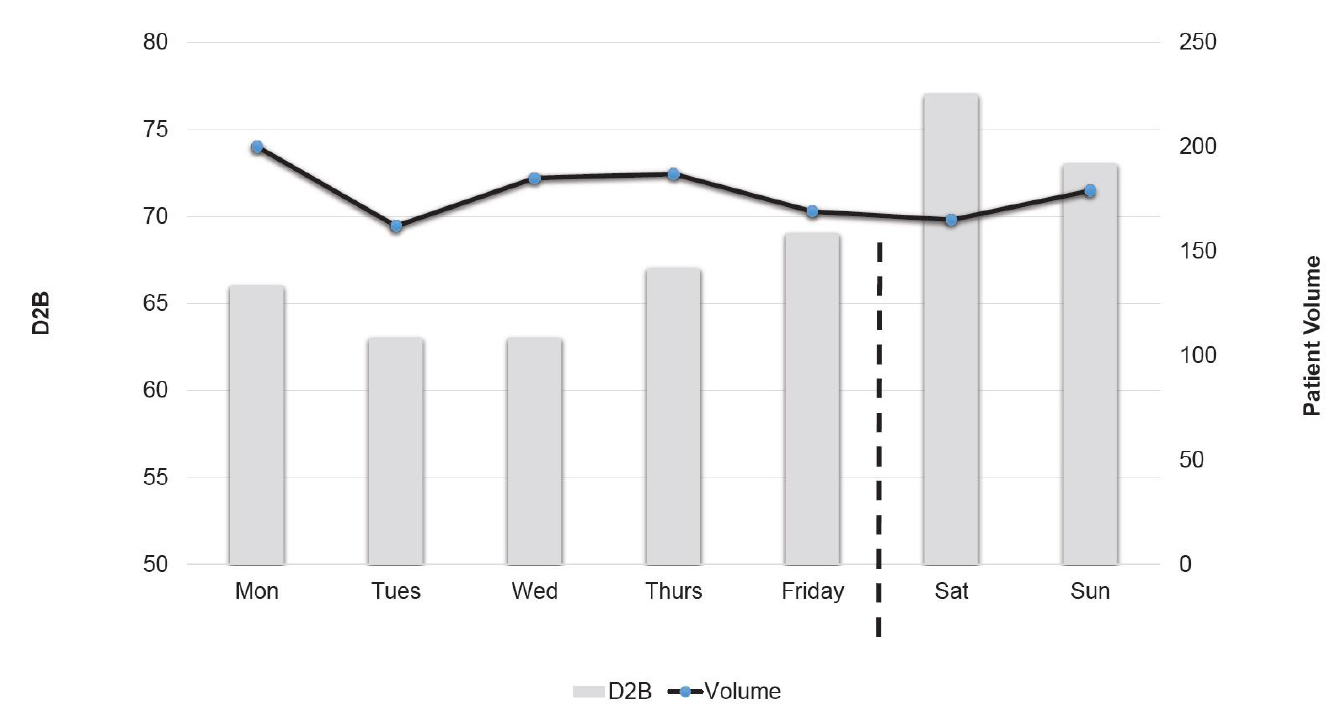
Figure 1. Volumes and median D2B for STEMI patients by day of week. STEMI, ST-elevation myocardial infarction; D2B ,